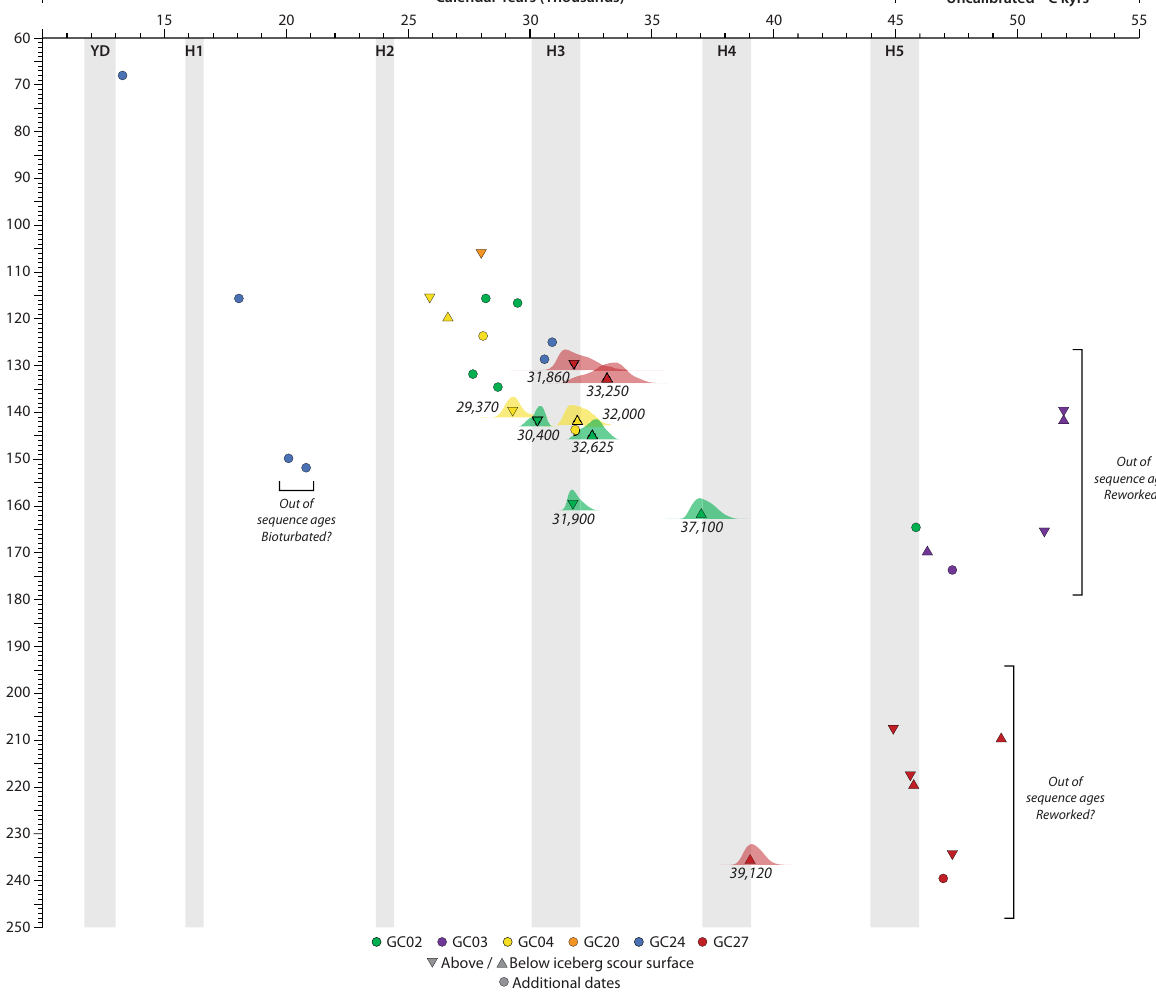
Fig. 4 Radiocarbon dates from sediment cores collected in and around buried iceberg scours. Median calendar ages, derived from radiocarbon calibration using Oxcal 4.3 are reported for samples younger than 45 kyr 14 C BP, while older samples are reported uncalibrated. Several of the cores show an erosional iceberg scour surface with ages above and below the surface that cluster around ~31 kyr cal BP. Several major climatic events (e.g., Younger Dryas, Heinrich Events) are highlighted with gray